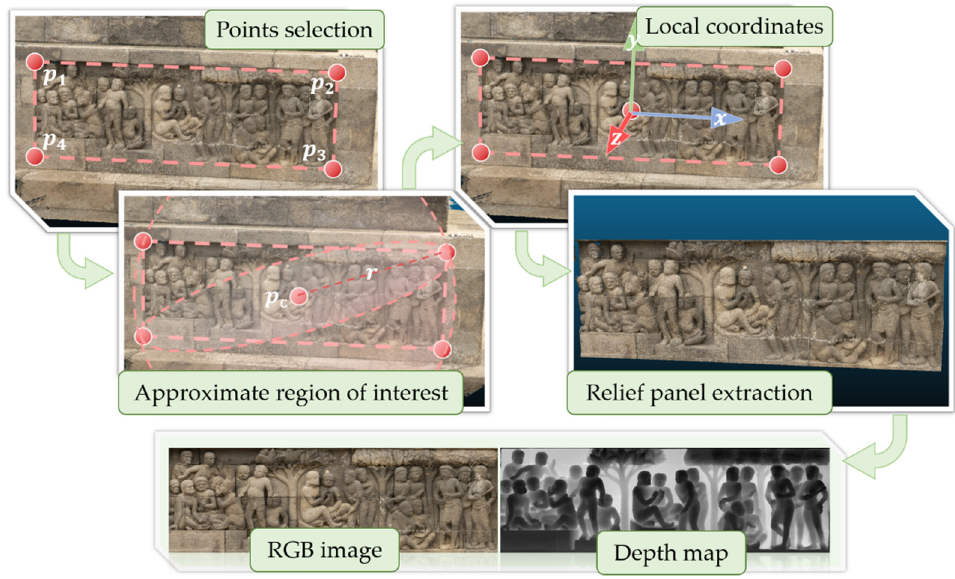
Figure 4. Relief panel extraction.